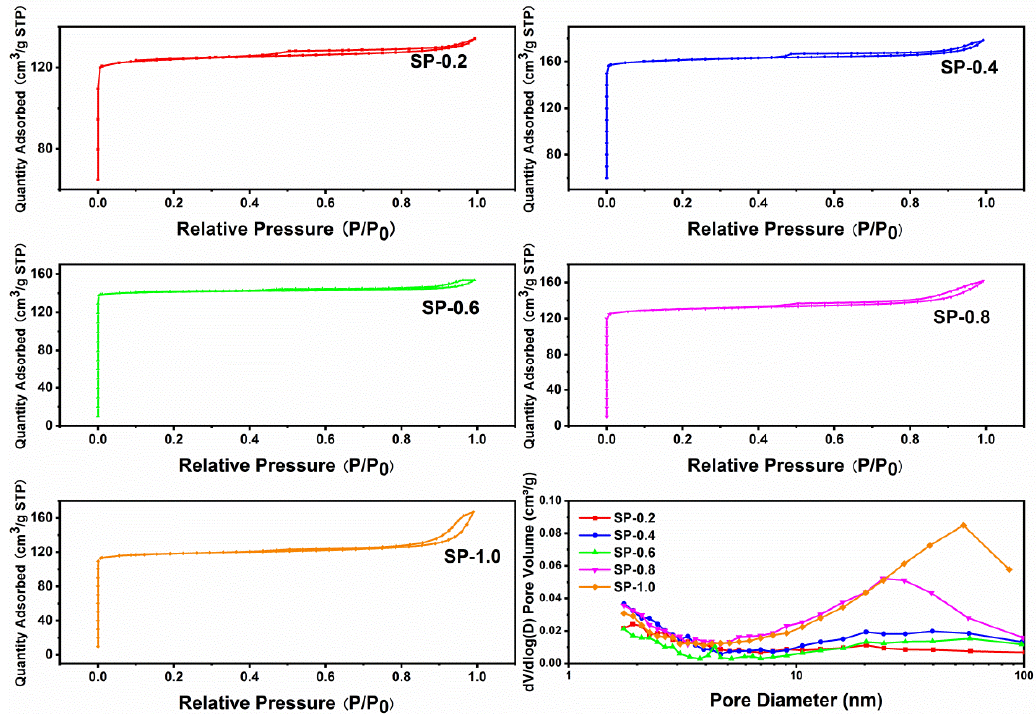
Figure 3. N 2 adsorption–desorption isotherms and BJH pore size distribution of as-synthesized samples. Table 2. Textural properties of as-synthesized samples.